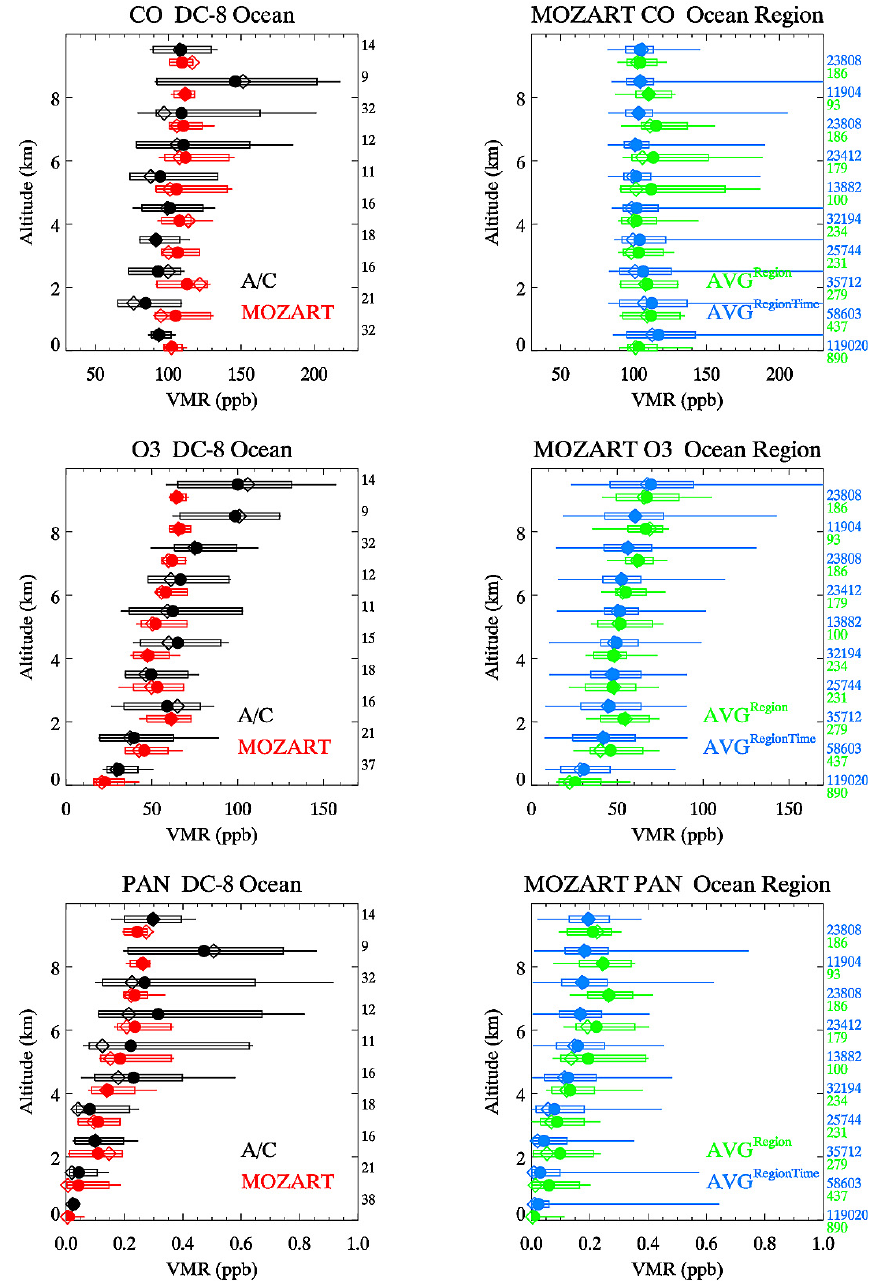
Fig. 2. Observed (black) and modeled (red) statistics for CO, O 3 and PAN vertical profiles along the DC-8 flight track (left-hand side) and for larger temporal and spatial averages (right-hand side; AVGRegion in green and AVGRegionTime in blue; see text and Fig. 1 for more explanation). Shown are mean (filled symbol), median (open symbols), 10th and 90th percentiles (bars) and extremes (lines). The number of data points per 1-km wide altitude bin is shown next to the